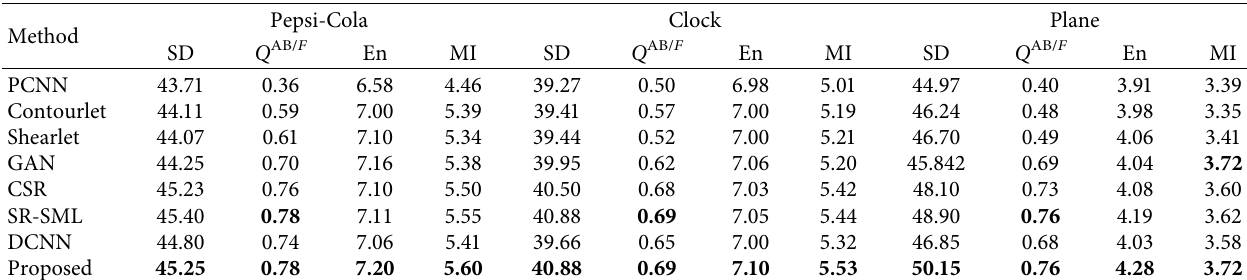
Table 1: The fusion performance of the seven methods and the proposed method from Figures 6–8.